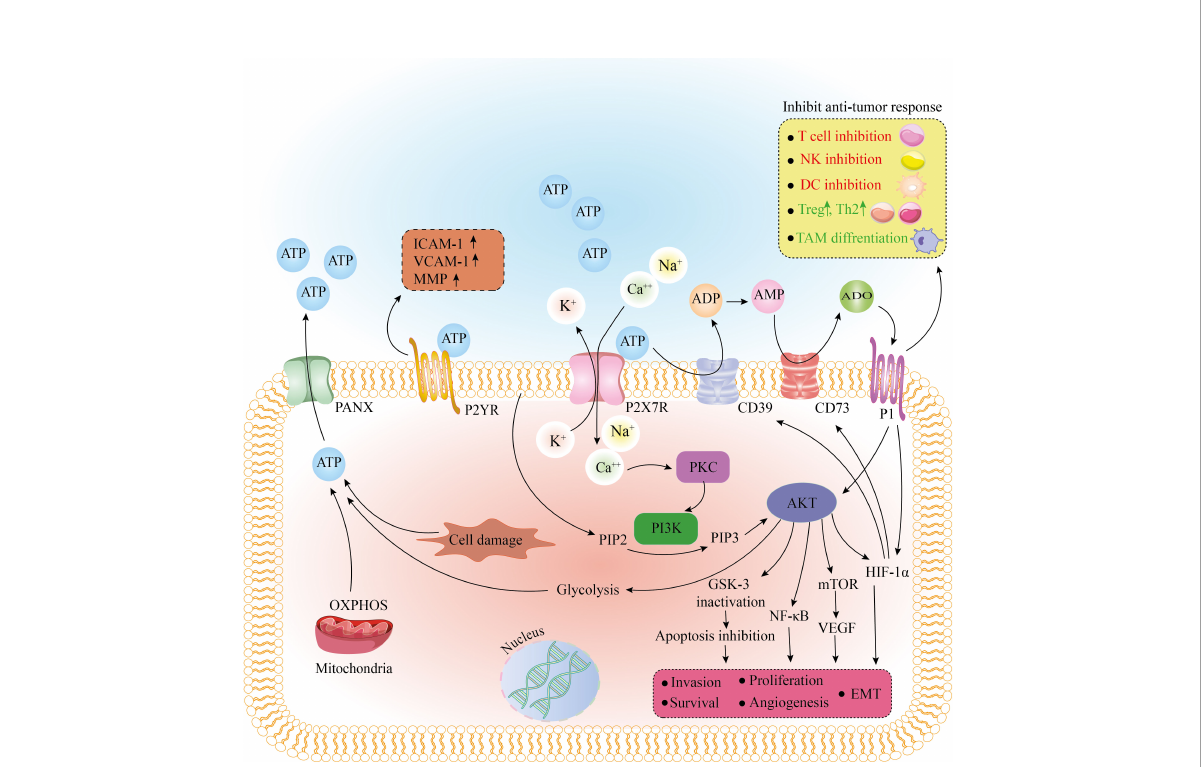
FIGURE 1 The effect of purinergic receptors on tumorigenesis and tumor cell metabolism. After binding to ATP, the purinergic receptor, P2X7R, removes K + from the cell as Ca 2+ and Na + enter the cell. Also, extracellular ATP, due to the enzymatic function of CD39 and CD73, is converted to AMP and ADO. By binding to P1 receptors, ADO has tumor-promoting effects by inhibiting the immune response. Stimulation of the P1 receptor also causes activation of Akt and HIF-1a. An increase in intracellular Ca 2+ activates PKC and PI3K, and PI3K by converting PIP2 to PIP3 activates Akt. As the main regulator, Akt activates HIF-1a, mTOR/VEGF, and NF-kb pathways and inactivates GSK-3, eventually leading to apoptosis inhibition, EMT, invasion, survival, and proliferation. Akt stimulates the glycolysis pathway. Glycolysis and OXPHOS or cell damage can produce ATP, leaving the cell through the PANX receptor. After binding to ATP, another purinergic receptor, P2YR, can increase ICAM-1, VCAM-1, and MMP, leading to adhesion and invasion of tumor cells. ADO, adenosine; AMP, adenosine monophosphate; ATP, adenosine triphosphate; CD39, cluster of differentiation 39; CD73, cluster of differentiation 73; DC, dendritic cell; EMT, epithelial-mesenchymal transition; GSK-3, glycogen synthase kinase-3; HIF-1a, hypoxia-inducible factor 1-alpha; ICAM-1, intercellular Adhesion Molecule 1; MMP, matrix metallopeptidase; mTOR, mammalian target of rapamycin; NF-kb, nuclear factor kappa B; NK cell, natural killer cell; OXPHOS, oxidative phosphorylation; PANX, pannexin; PI3K, phosphoinositide 3-kinases; PIP2, phosphatidylinositol-4, 5-bisphosphate; PIP3, phosphatidylinositol-3, 4, 5-triphosphate; PKC, protein kinase C; TAM, tumor-associated macrophage; Th2, T helper type 2; Treg, regulatory T cell; VCAM-1, vascular cell adhesion molecule 1; VEGF, vascular endothelial growth